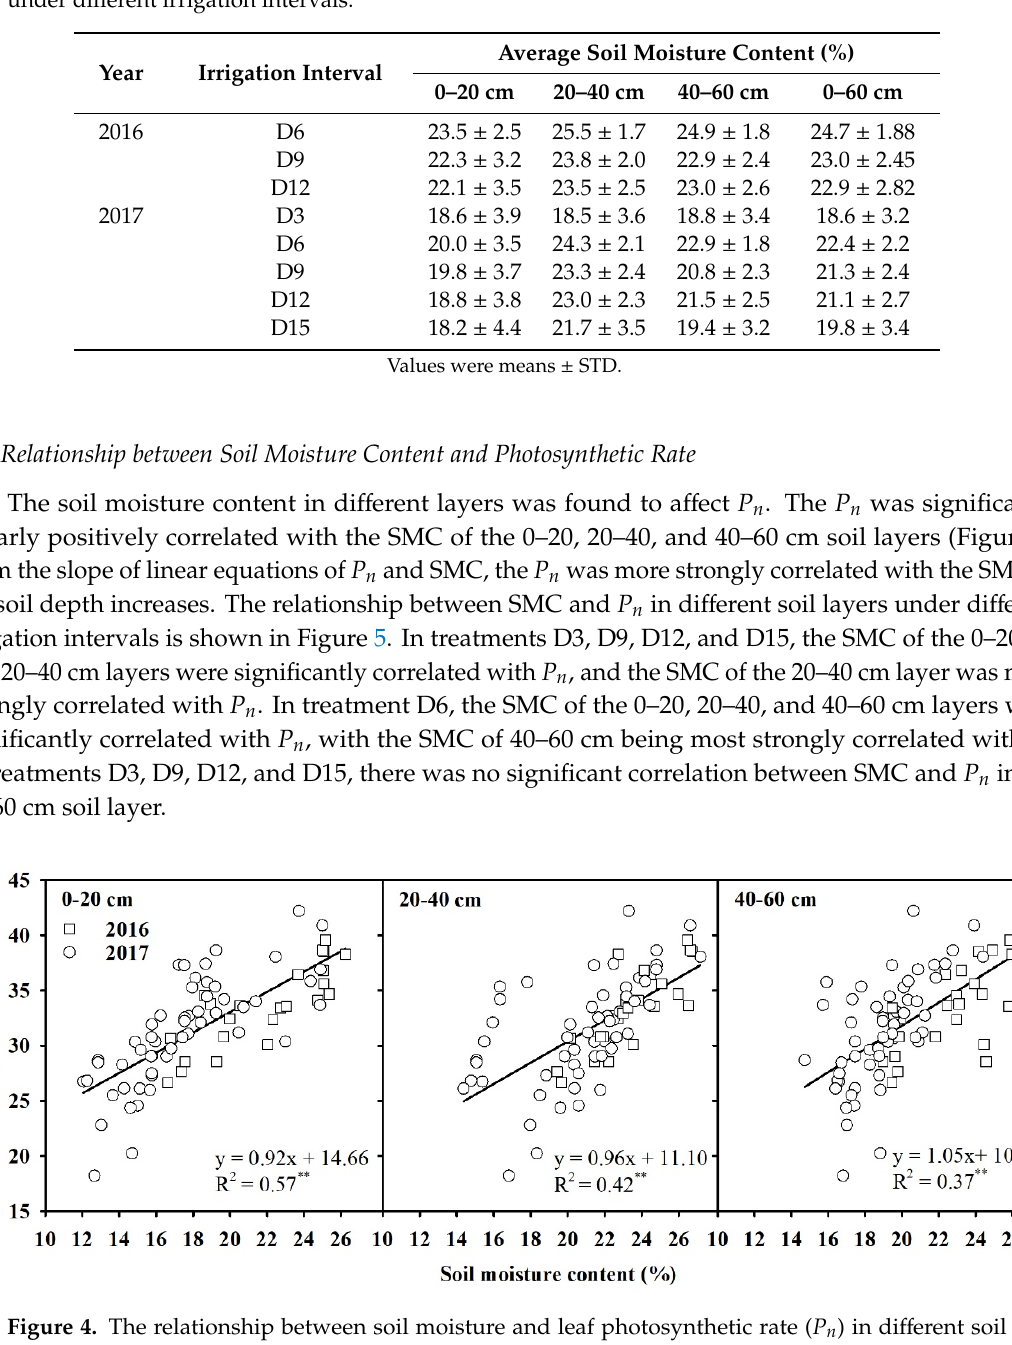
Figure 4. The relationship between soil moisture and leaf photosynthetic rate ( P n ) in different soil layers. ** significant at 0.01